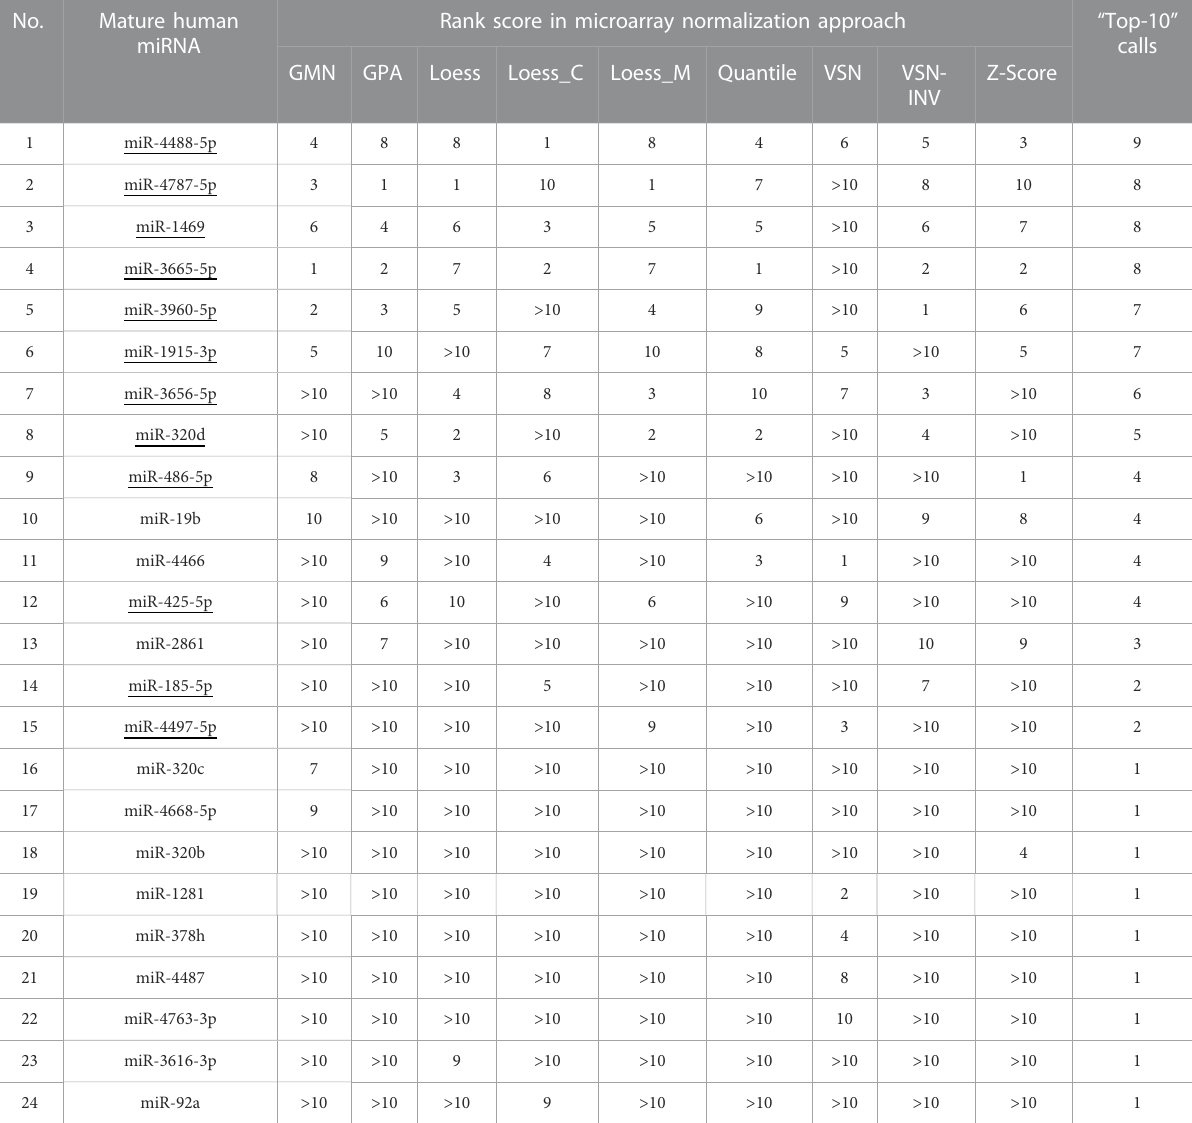
TABLE 1 Number of top-ten ranks of consistently expressed human plasma miRNAs across nine approaches for microarray data normalization. No. Mature human Rank score in microarray normalization miRNA